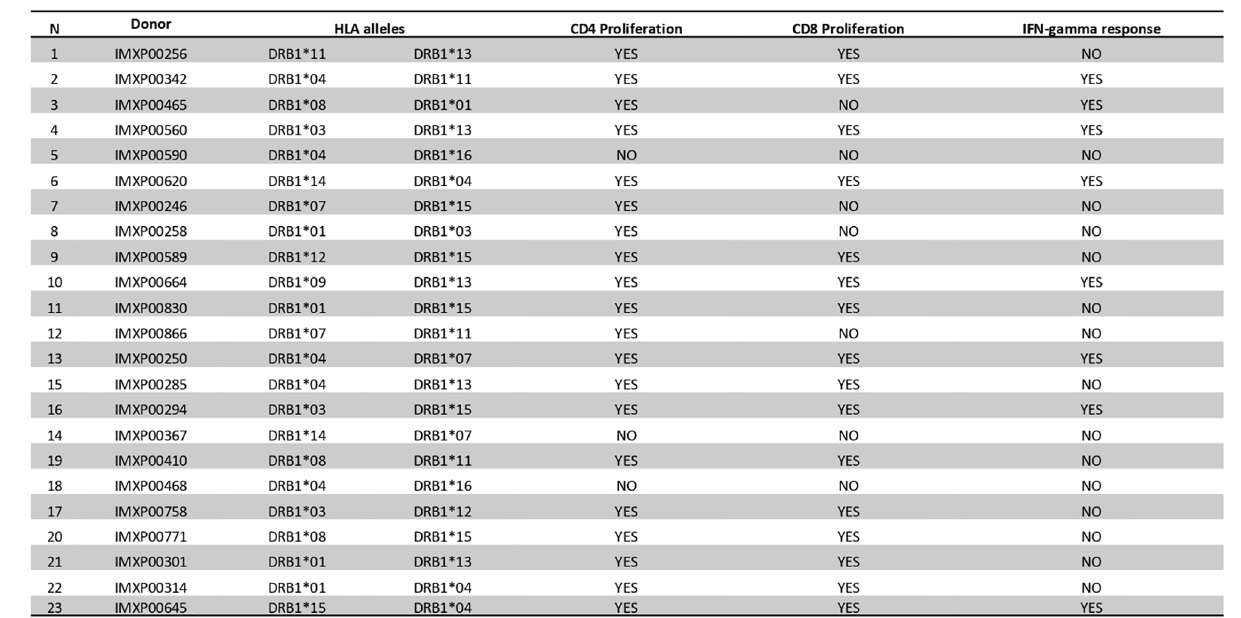
FIGURE 6 | BpOmpW (homologue OmpW in Burkholderia pseudomallei ) induced T-cell proliferation in human peripheral blood mononuclear cells (PBMCs). A table showing a qualitative description (YES/NO) based on the differential signi fi cance of CD4 + and CD8 + T-cell proliferation and the overall IFN- g responses of 23 donor PBMCs in response to BpOmpW or BpOmpW+SAS and SAS control is included. The table also shows the human leukocyte antigen (HLA) alleles of each donor. YES / NO denote signi fi cant differences ( p < 0.05) according to two-way